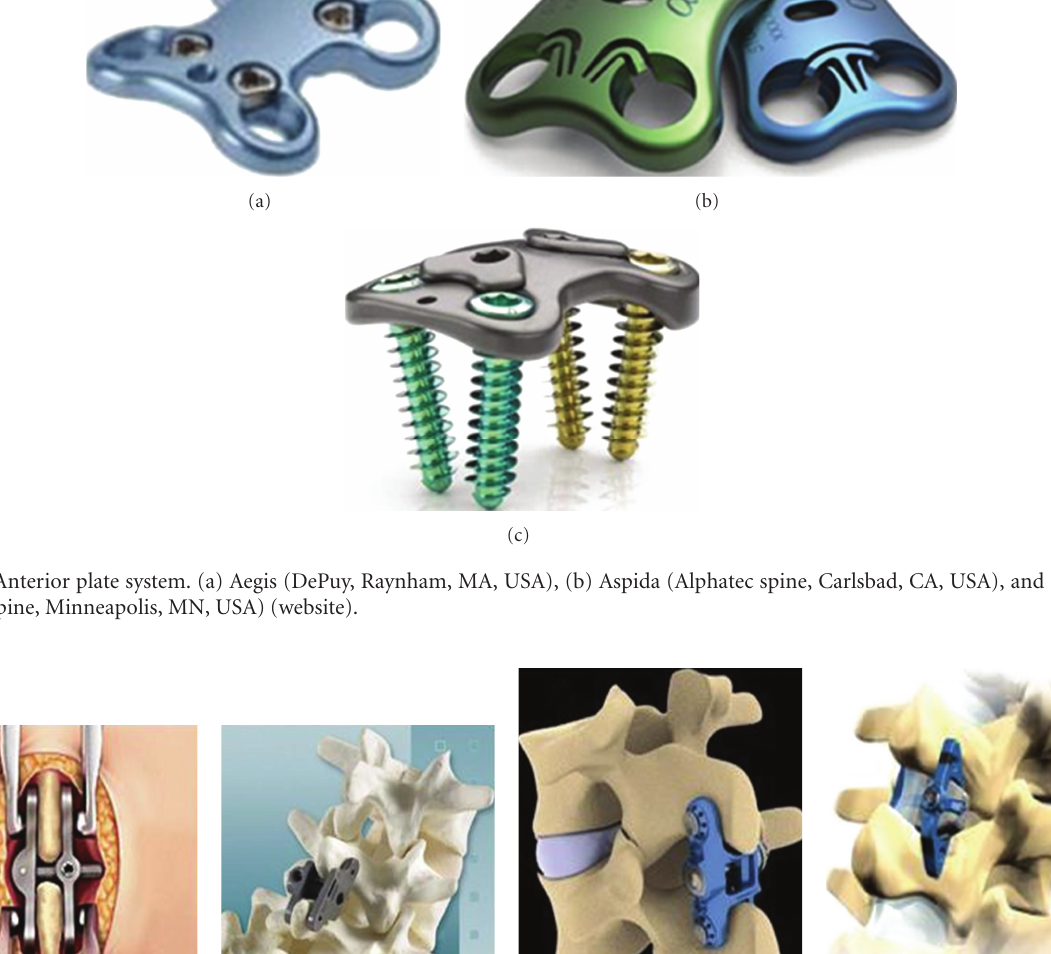
and 121 KPa in PEEK, 146.4, 132.6, 57.5, and 160 KPa